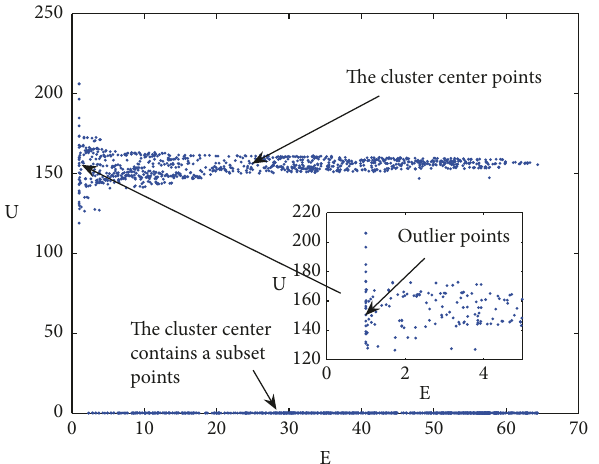
Figure 5: Clustering graph based on data field energy